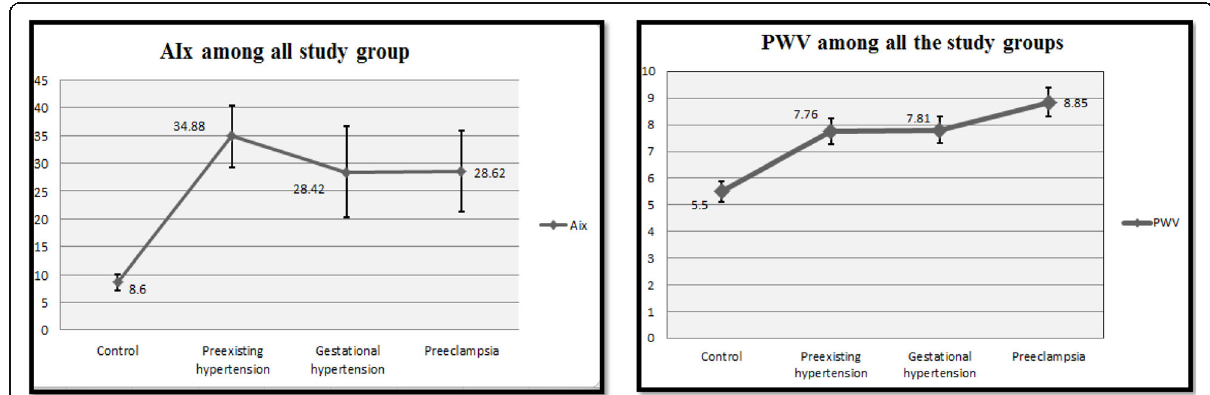
Fig. 4 a Augmentation index in different study groups (ANOVA test of difference showed a significant p value < 0.001), and b pulse wave velocity in the different study groups ( p = 0.03). AIx, augmentation index; PWV, pulse wave TensioClinic TL1 Arteriograph and TensioClinic soft-